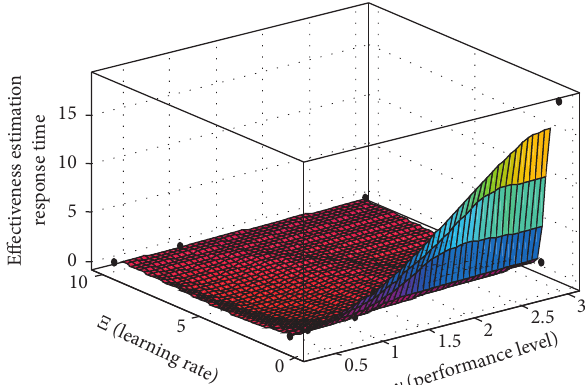
Figure 17: The effectiveness estimation response time with respect to the learning rate and the performance level.